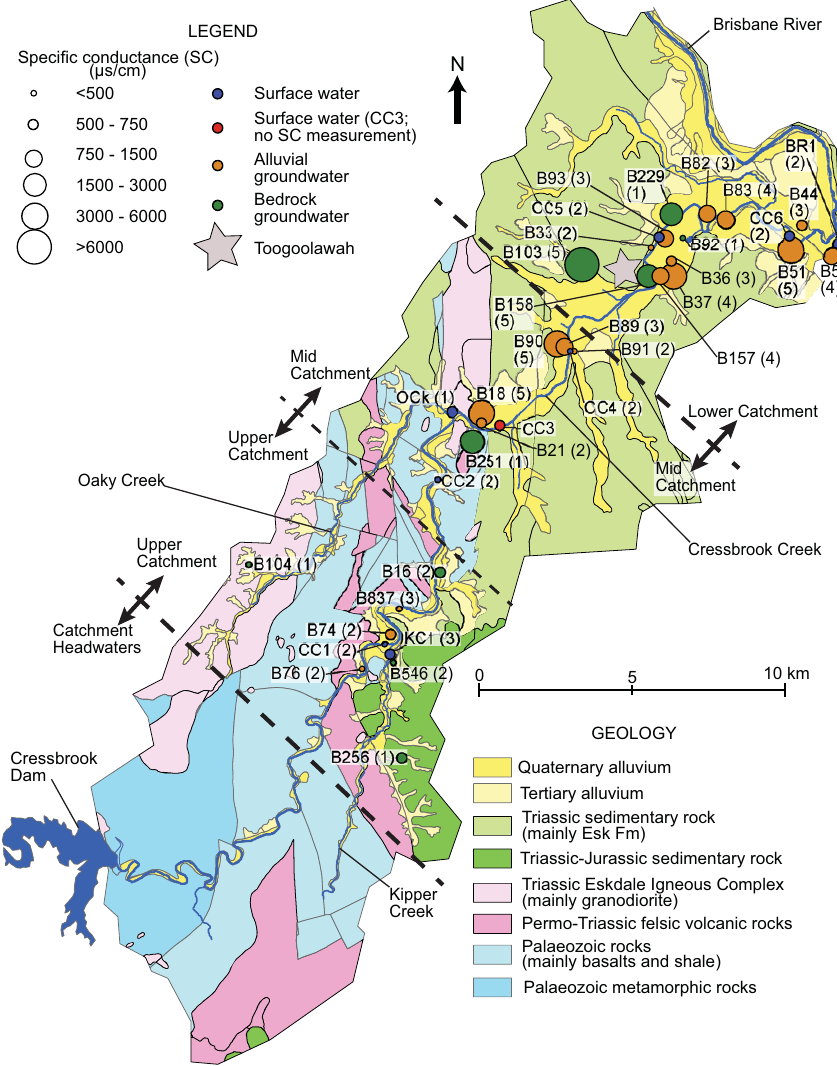
Figure 3. Location of sampling sites, and catchment-wide distribution of specific conductance (SC) and hydrochemical facies distribution (in parentheses; Sect. 5.1.1) in the Cressbrook Creek catchment. The samples were collected in June 2011 (see Table 3 for exact